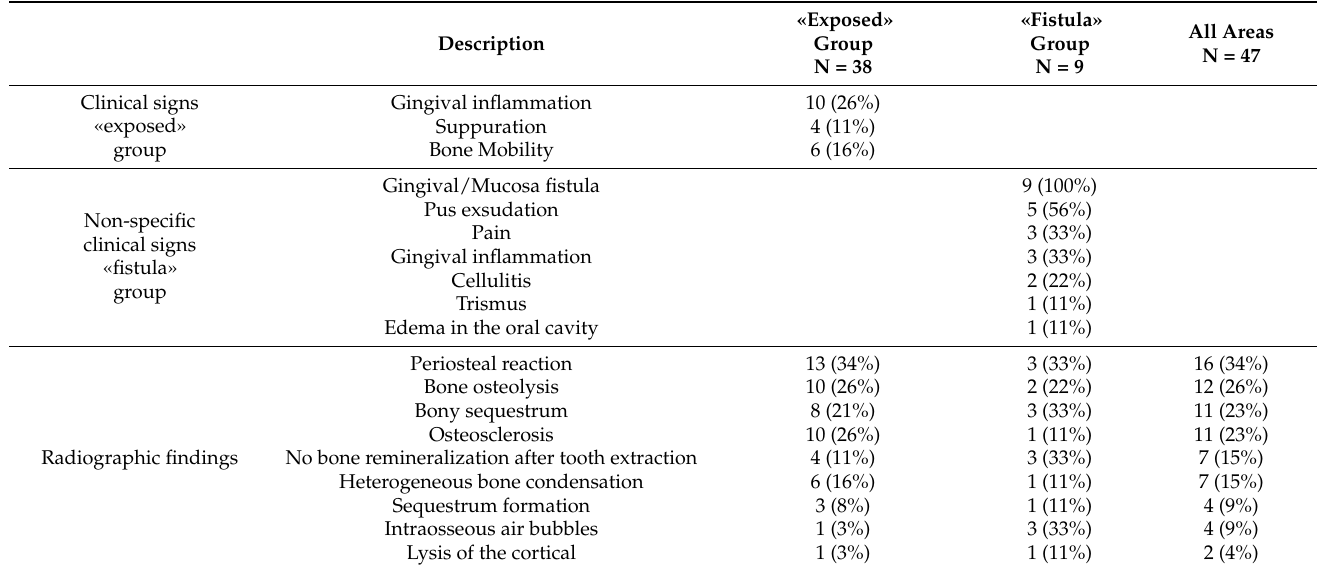
Table 3. Clinical and radiographic features of